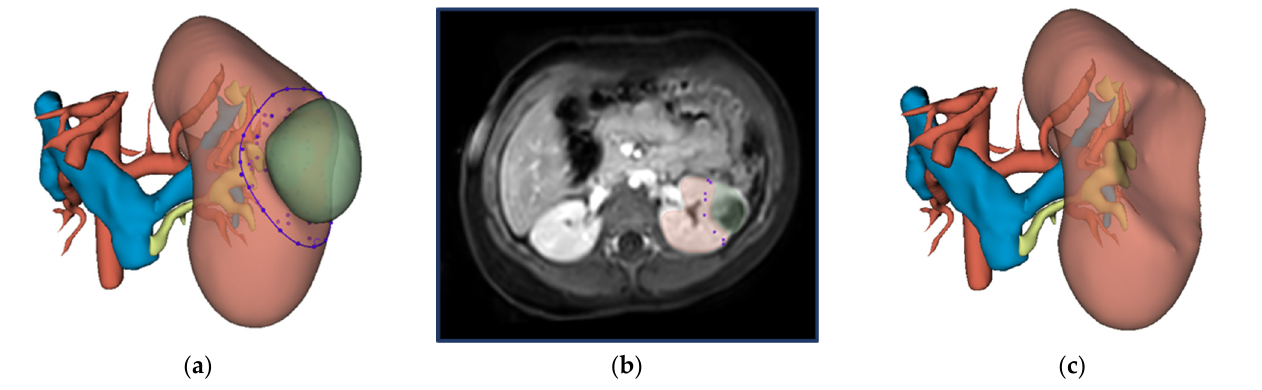
Figure 1. Workflow for virtual resection in 3D Slicer: ( a ) 3D visualization of the kidney, tumor, urinary collecting system, renal artery and renal veins. The closed curve as selected by the surgeon is indicated in purple. ( b ) Preoperative MRI imaging (post-contrast fat-suppressed T1-weighted) of the abdomen with the kidney and WT segmentation in red and green, respectively. The surgeon selected intraparenchymal points on this MRI scan. ( c ) 3D visualization of the virtual kidney volume after virtual resection.